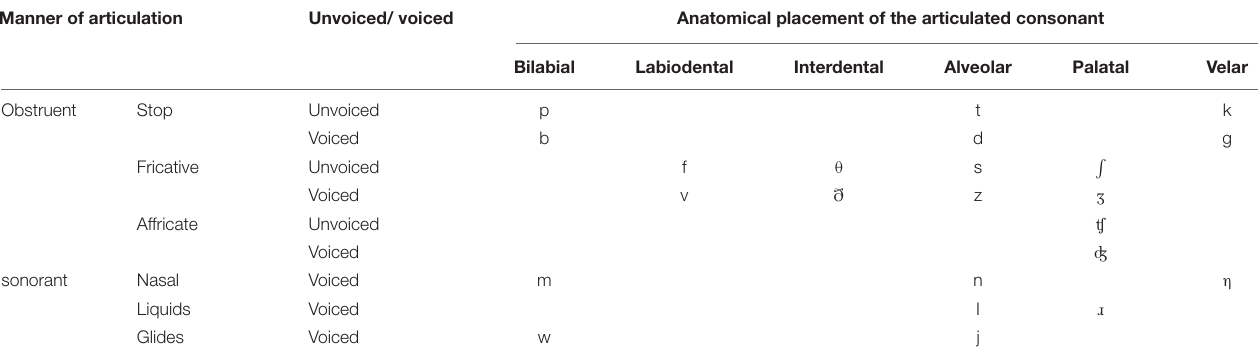
TABLE 3 | Voiced and unvoiced consonants described anatomically and according to the manners of articulation (O’Grady et al., 2017). Manner of